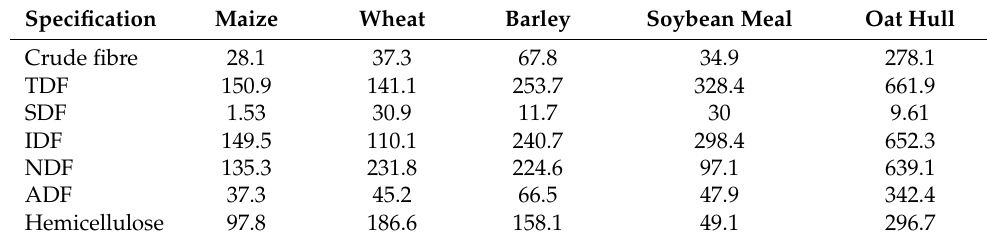
Table 2. Composition of structural carbohydrates in components (g · kg − 1 ).